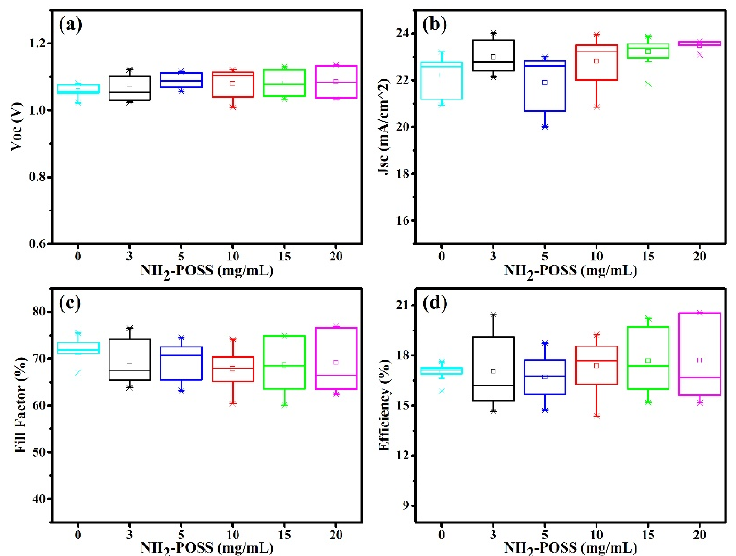
Figure 6. Photovoltaic metric for perovskite solar cells fabricated with different concentrations of NH 2 -POSS. ( a ) open-circuit (V oc ), ( b ) short-circuit (J sc ), ( c ) fill factor (FF), and ( d ) power conversion efficiency (PCE ).